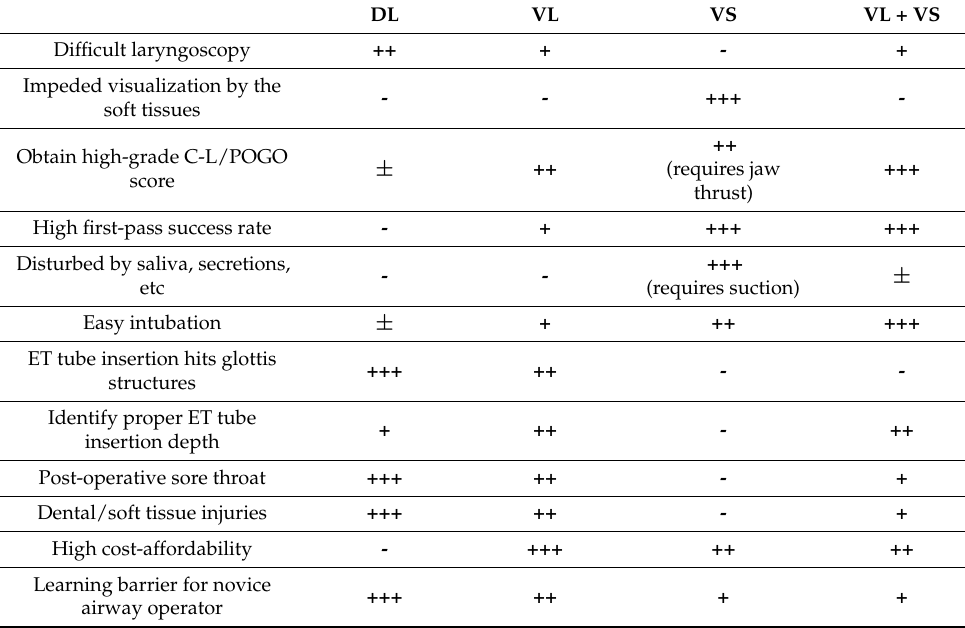
Table 2. Qualitative comparison of various tracheal intubation modalities. DL VL VS VL +